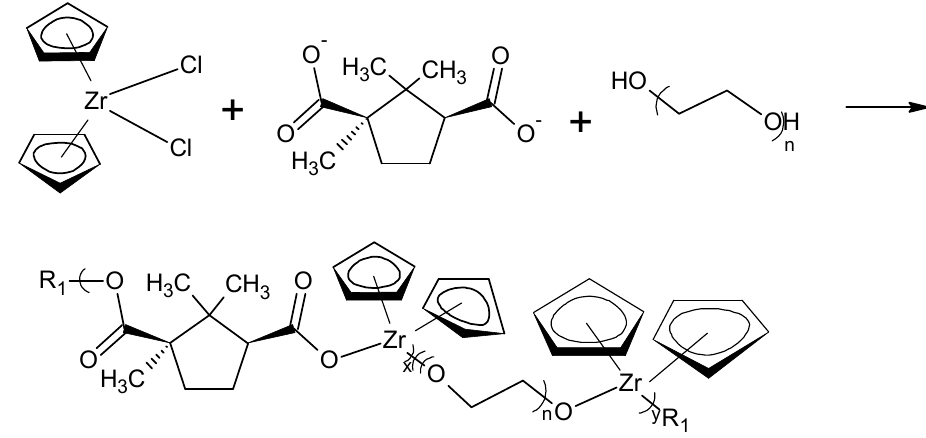
Figure 3. Reaction scheme for the reaction between D ‐ camphoric acid and zirconocene dichloride, where R 1 represents a simple chain extension. Processes 2017 , 5 , 50